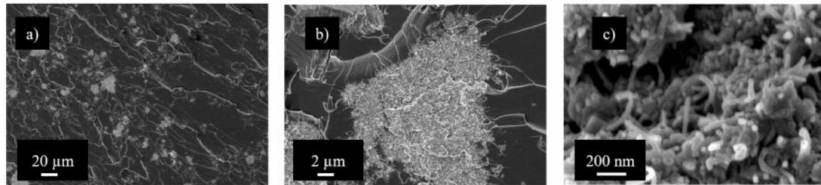
Figure 6. FESEM crio-fractured surface of the composite with different magnification ( a ) 1.0 kX, ( b ) 10.0 kX µ m, ( c ) 200 kX